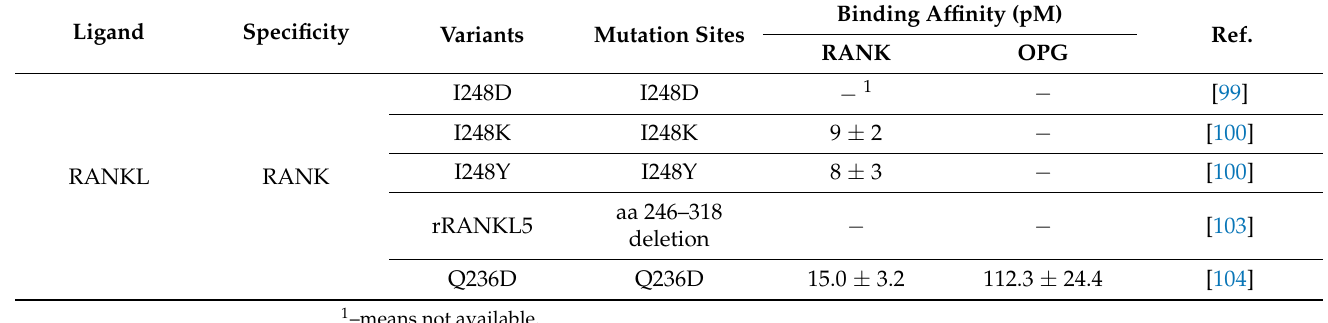
Table 3. The mutation sites and binding affinity of the receptor-specific RANKL variants.